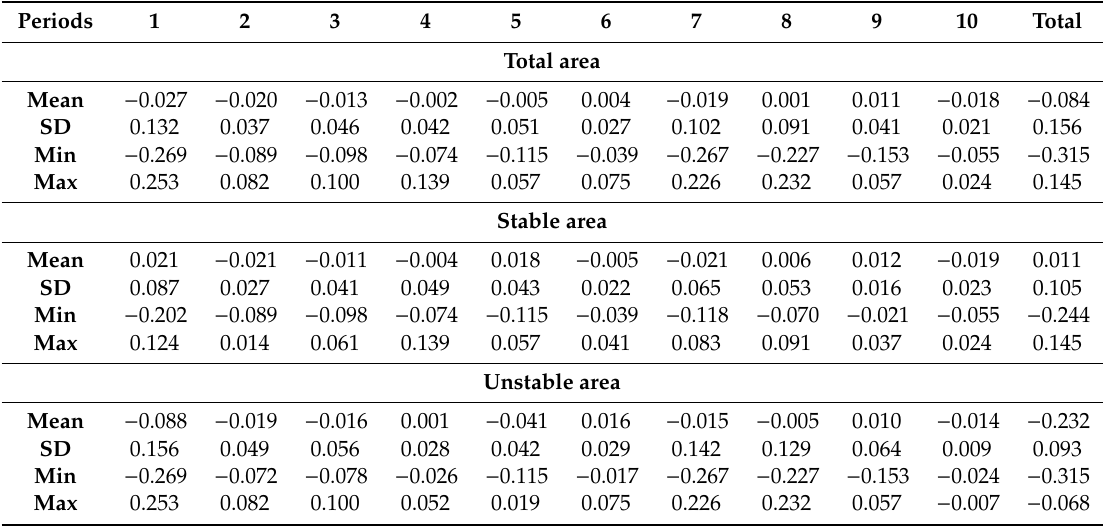
Table 5. Vertical (Z) displacements (in m) of the monitoring points in the di ff erent